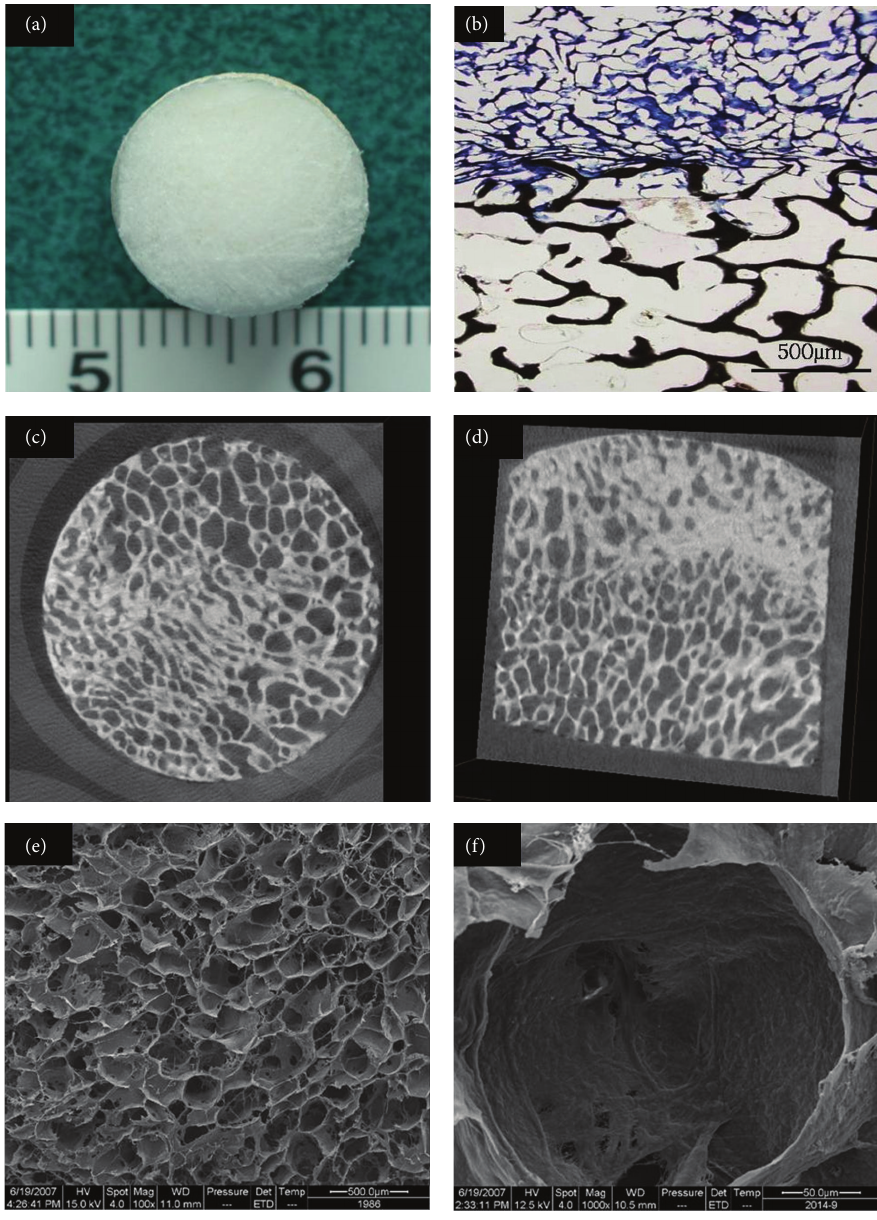
Figure 3: Scaffold structure and histology: (a) morphology of the scaffold, (b) Giemsa staining of nondecalcified section ( × 100), (c) cross- section of micro-CT image, (d) longitudinal section of micro-CT image, and scanning electron microscopy (SEM) of cartilage layer of scaffold (e) ( × 100) and (f) ( ×